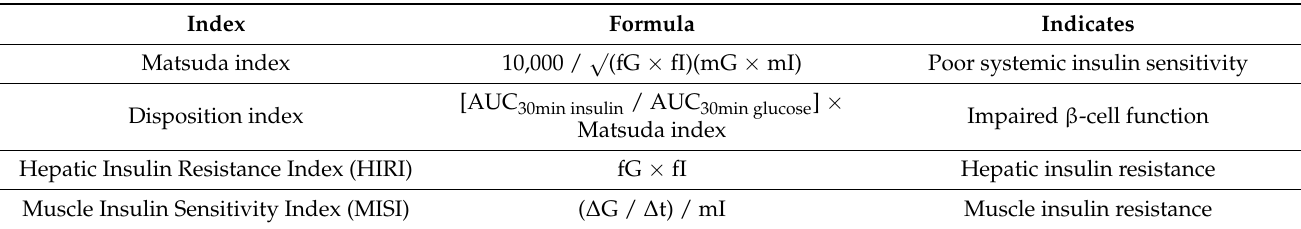
Table 1. Mathematical formulas and indication for glucose- and insulin-derived indices used for diabetyping [7–10]. Index Formula Indicates Matsuda index Poor systemic insulin sensitivity [AUC 30min insulin / AUC 30min glucose ] × Disposition index Impaired β -cell function Matsuda index Hepatic Insulin Resistance Index (HIRI) Muscle Insulin Sensitivity Index (MISI) ( ∆ G / ∆ t) / mI Muscle insulin resistance fG = fasting plasma glucose; fI = fasting plasma insulin; AUC = area under the curve; mG = mean plasma glucose; mI = mean plasma insulin; ∆ G = delta glucose; ∆ t = delta